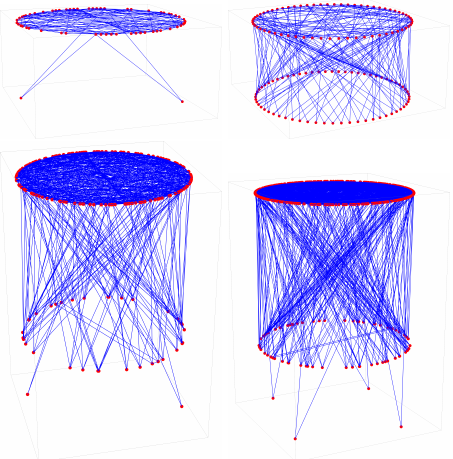
Figure 5. Three-dimensional base space graphs: ¯ G 59 ( top left ); ¯ G 96 ( top right ); ¯ G 323 ( bottom left ); and ¯ G 646 ( bottom right ).